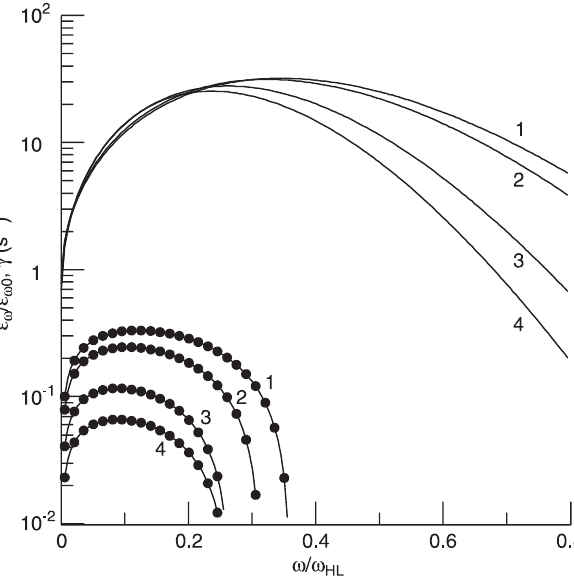
Fig. 7. The dependencies of growth rate ( lines with dots ) and intensity on frequency for strong di(cid:128)usion for di(cid:128)erent u values D v = v 0 (cid:136) 0 : 6 ; u (cid:25) 0 : 18 (cid:14) ; u (cid:25) 0 : 2 (cid:14) ; u (cid:25) 0 : 32 (cid:14) ; other parameters are as in Fig. 1 1 2 3